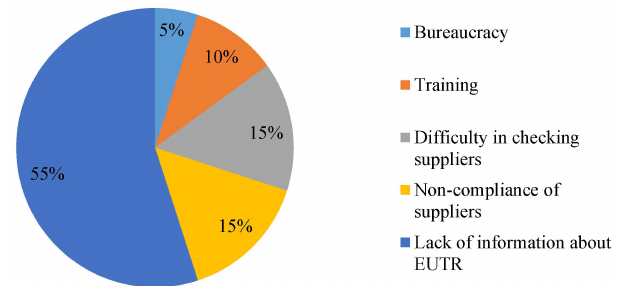
Figure 5. Problems in implementing EUTR.